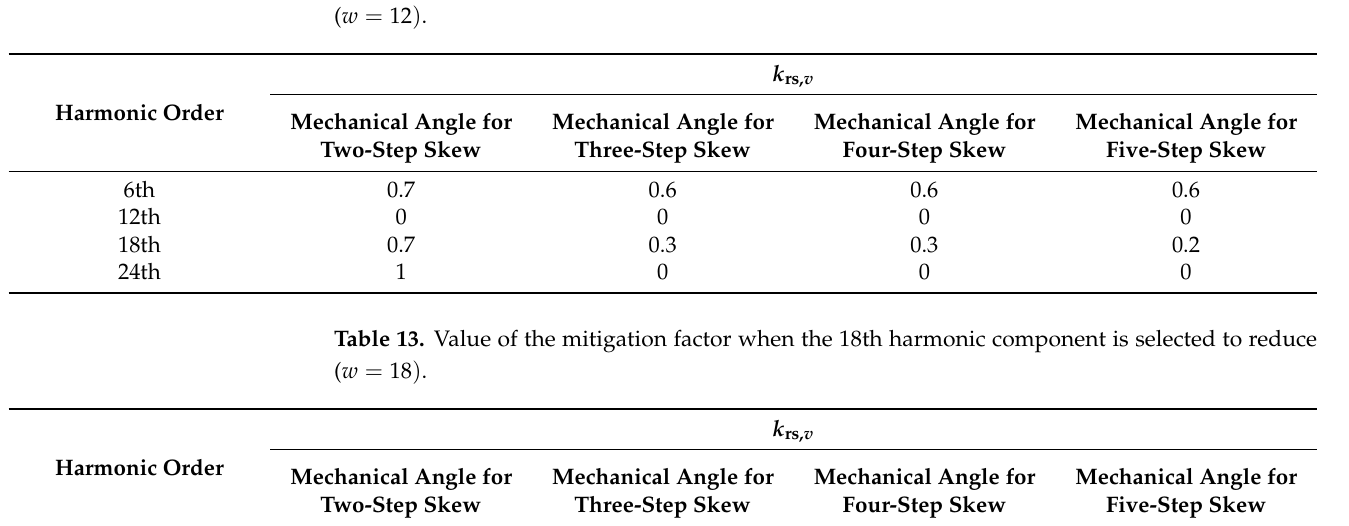
Table 12. Value of the mitigation factor when the 12th harmonic component is selected to reduce ( w = 12 ) .